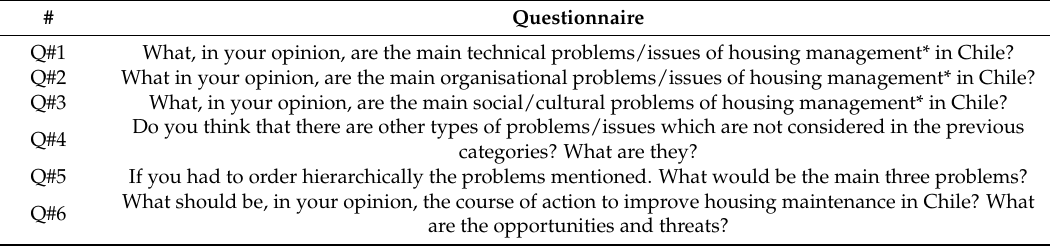
Table 3. Questionnaire individual interviews with housing